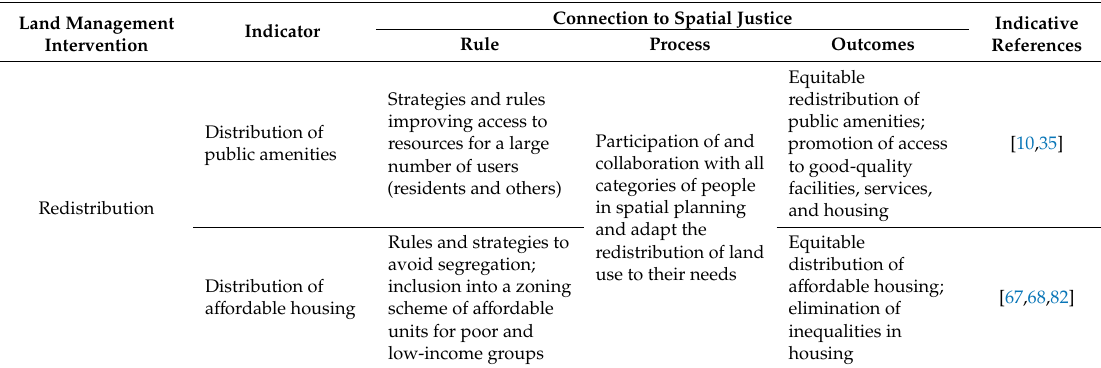
Table 4. Indicators related to the redistribution of